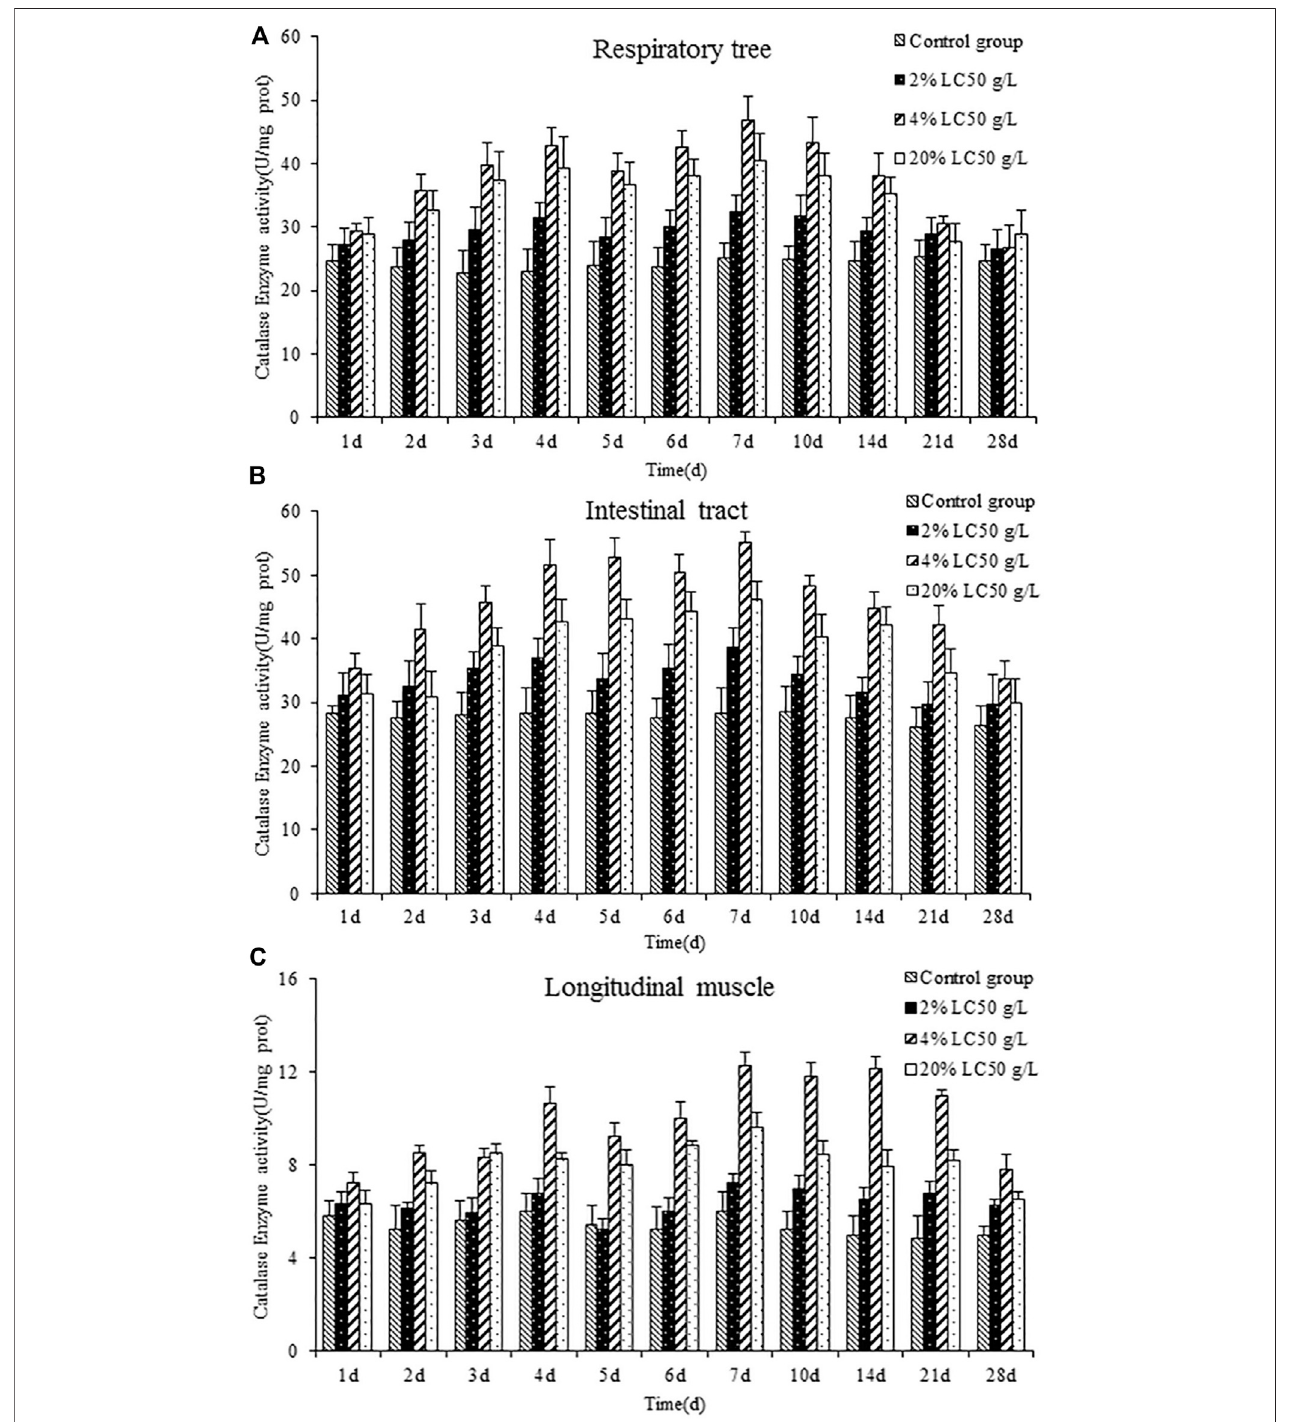
FIGURE 3 | catalase activity of the respiratory tree (A) , intestinal tract (B) , and longitudinal muscle (C) in A. japonicas .